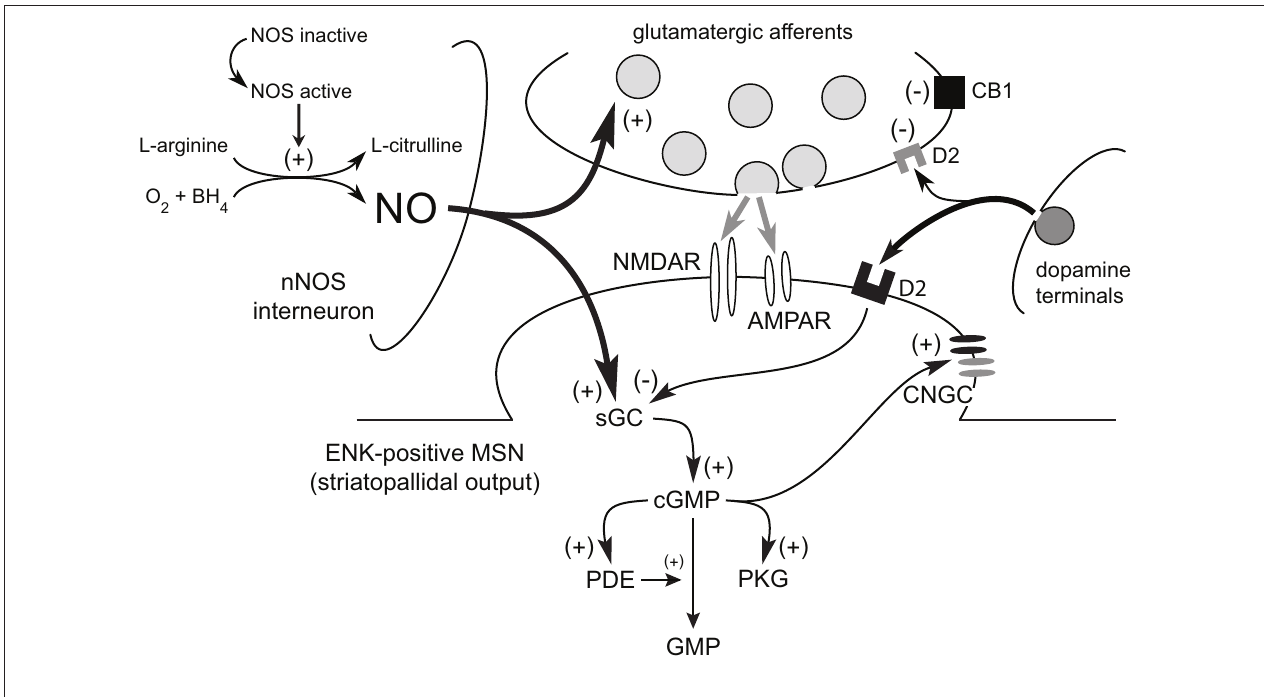
affect MSN activity via activation of PKG and downstream targets (e.g., cyclic nucleotide gated channels; CNGC). Numerous phosphodiesterases (PDEs), which metabolize cyclic nucleotides, limit the effects of cGMP on MSN function. In striatopallidal output neurons (ENK-positive MSN), the facilitatory action of cGMP may be directly opposed via D2